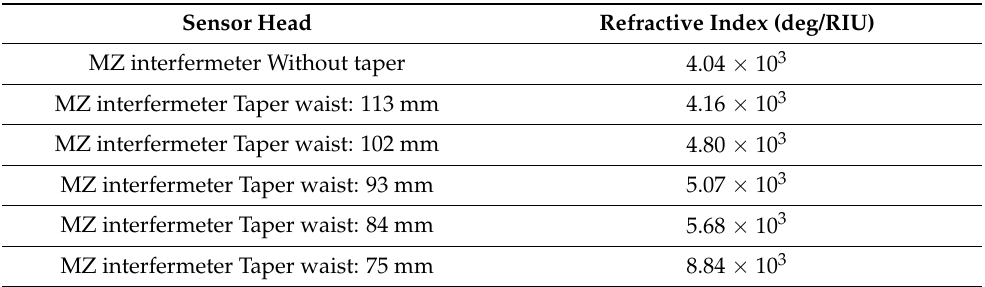
Figure 18. Sensing system phase changes due to refractive index variations for a tapered LPG-based Mach–Zehnder interferometer with different taper waist diameters. System phase difference versus taper waist diameter when the external medium refractive index changes from 1.33 to 1.42. Table 2 resume the results of the Mach–Zehnder modal interferometer with different taper waist diameters. Table 2. Resume of the results obtained with the Mach–Zehnder modal interferometer with different taper waist